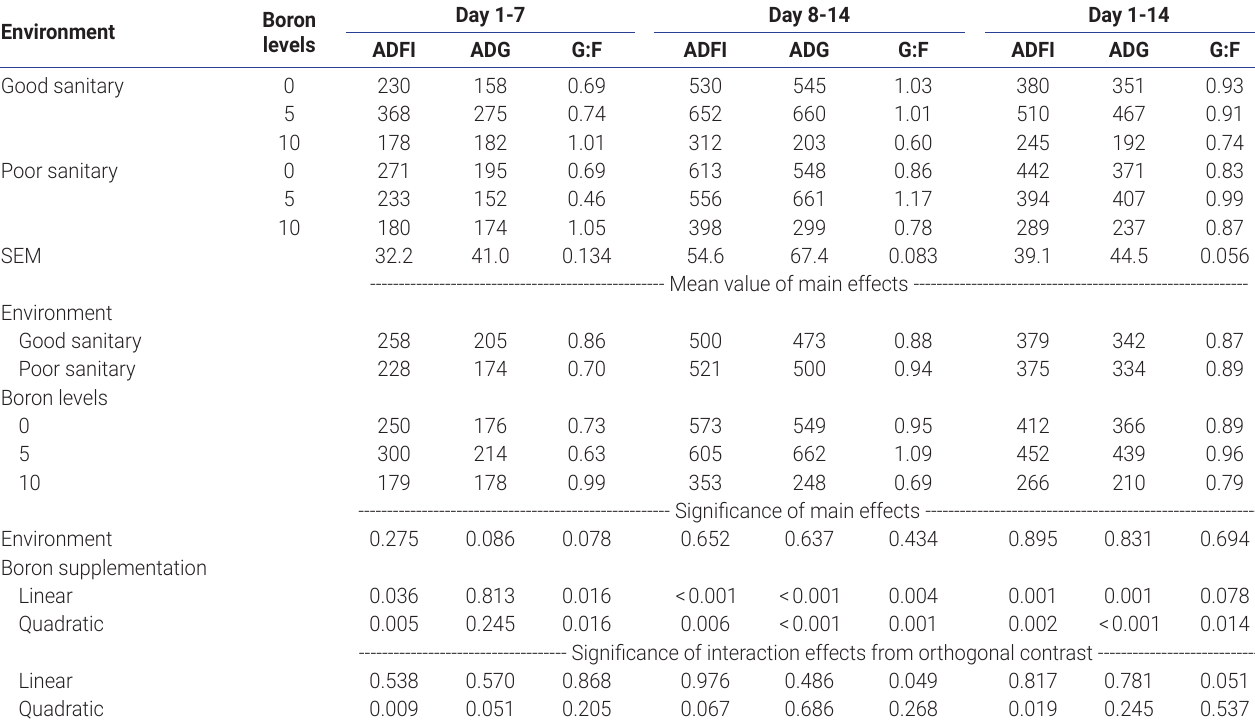
Table 2. Effects of environment and boron levels (mg/kg) on average daily gain (ADG, g/pig/d), average feed intake (ADFI, g/pig/d) and gain-to- feed ratio (G:F, g/g) in weaned pigs from day 1 to 14